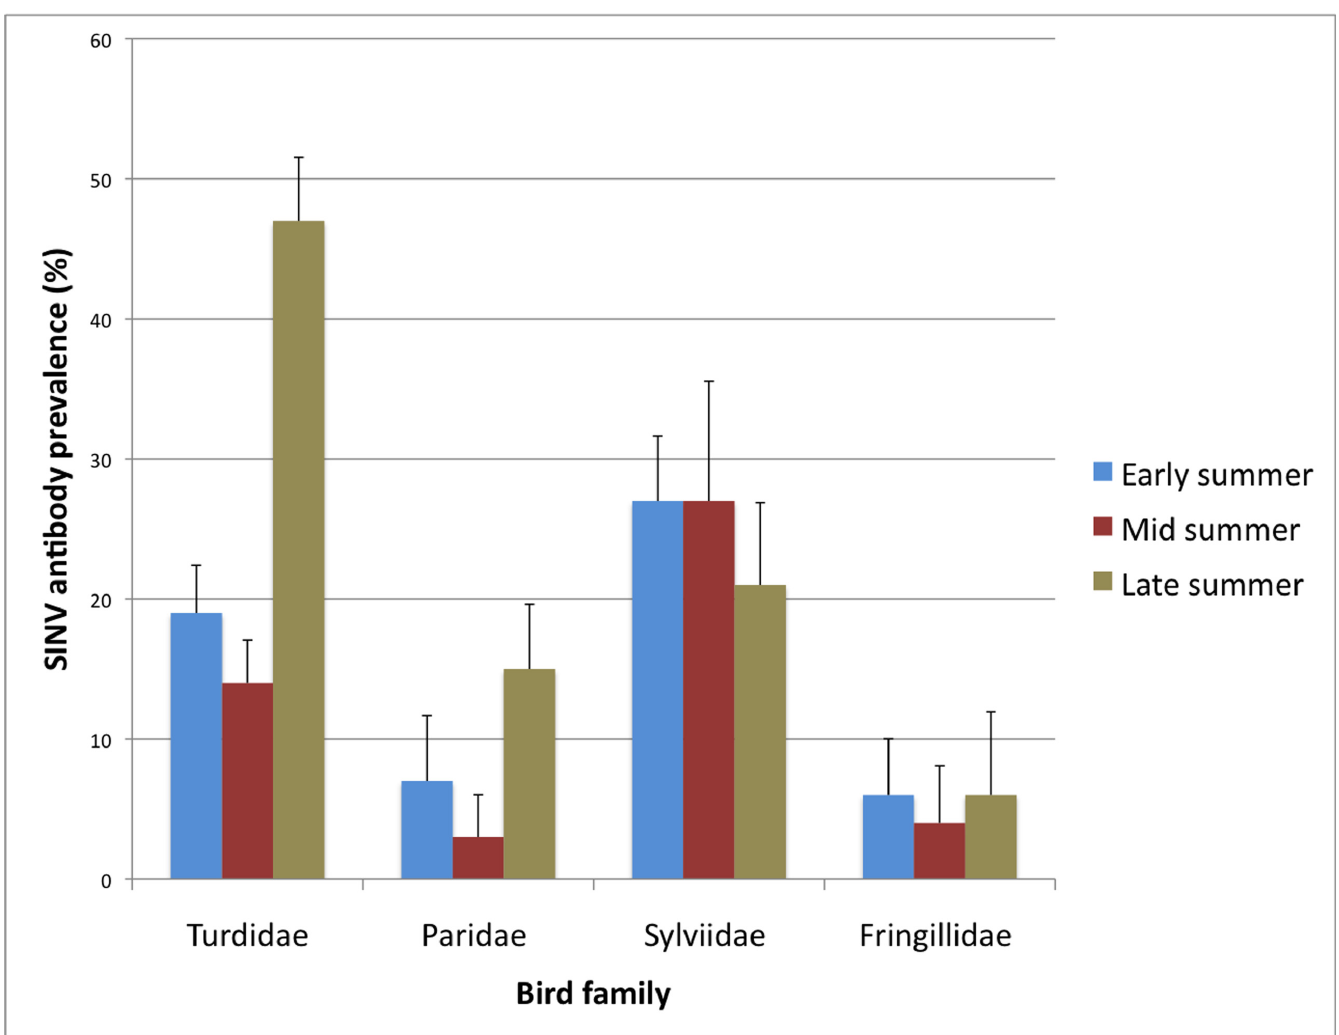
Fig 2. Prevalence of Sindbis virus neutralizing antibodies in four different passerine families. Error bars indicate SEM.